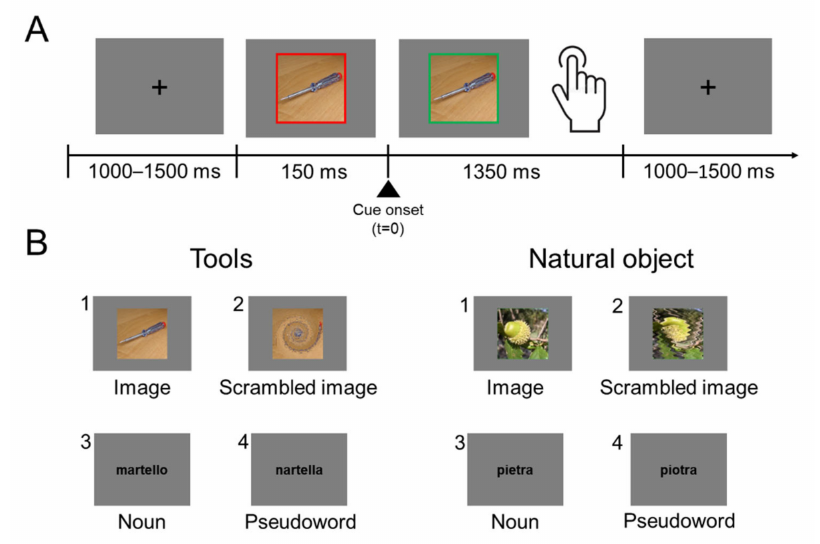
Figure 1. Experimental procedure. ( A ) Task timing: Participants were asked to fixate the center of the screen placed in front of them. Each trial started with the presentation of the stimulus surrounded by a red frame. After 150 ms the frame turned green and the participants were allowed to respond. Participants were instructed to respond only if the stimulus referred to a real tool or to a real natural graspable object. The trial ended when participants provided their responses or after 1350 ms if no response was given. ( B ) Stimuli examples: images (1), scrambled images (2), nouns (3) and pseudowords